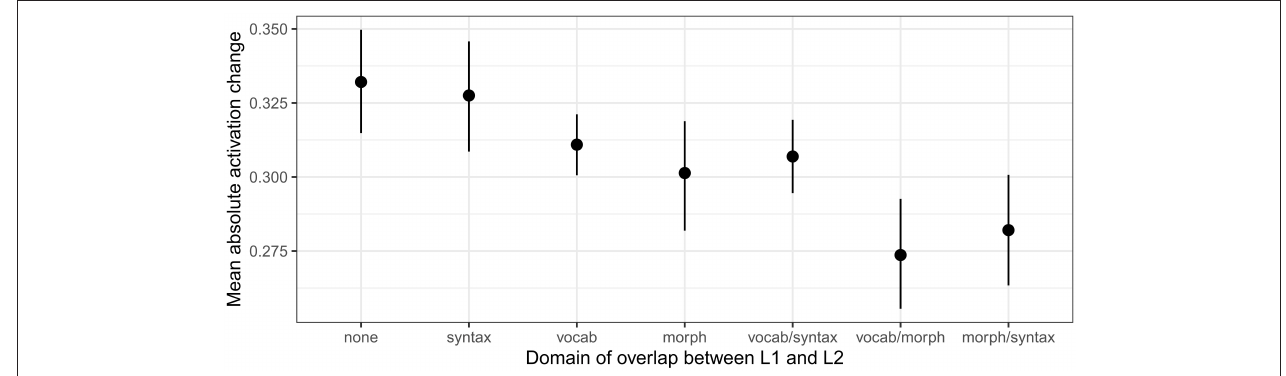
FIGURE 4 | Absolute cell activity change for models learning L2 after L1, averaged across all 100 hidden cells, organized by the domain in which language pairs overlapped.